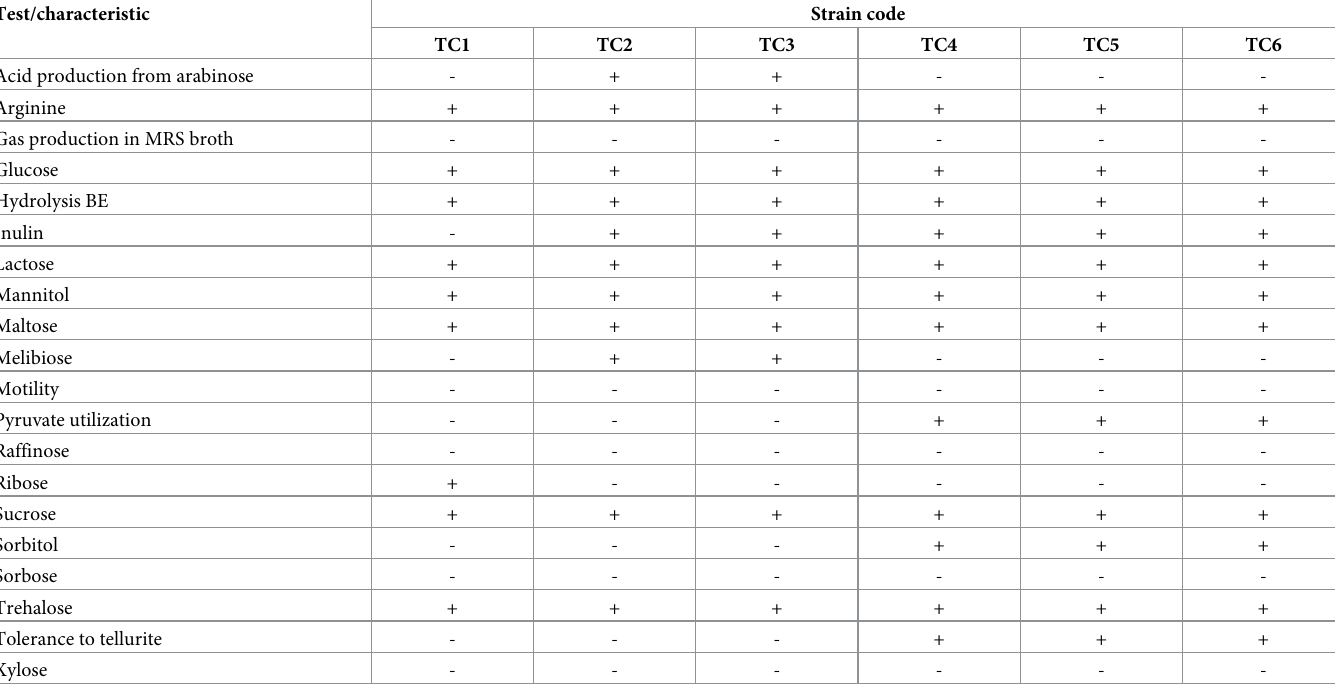
Table 2. Physiological characteristics of Enterococcus strains isolated from the intestinal microbiota of healthy pigs.